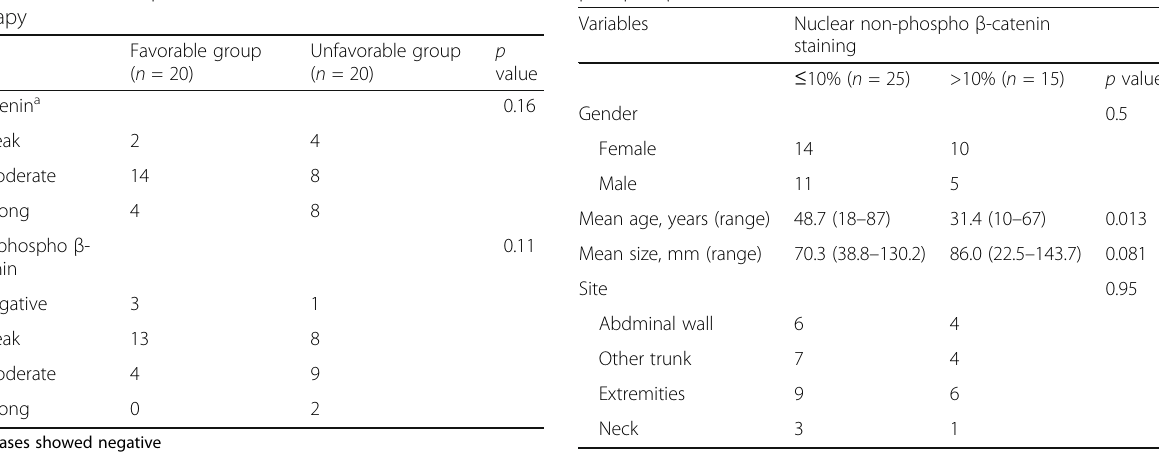
Table 5 Clinical variables and nuclear positivity for